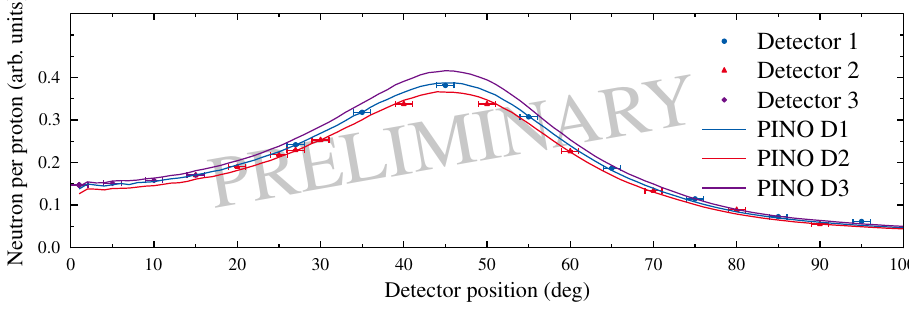
Figure 2. Neutron-per-Proton distribution over the measured angles. Each detector was simulated individually due to unique specifications and minor di ff erences in target-detector